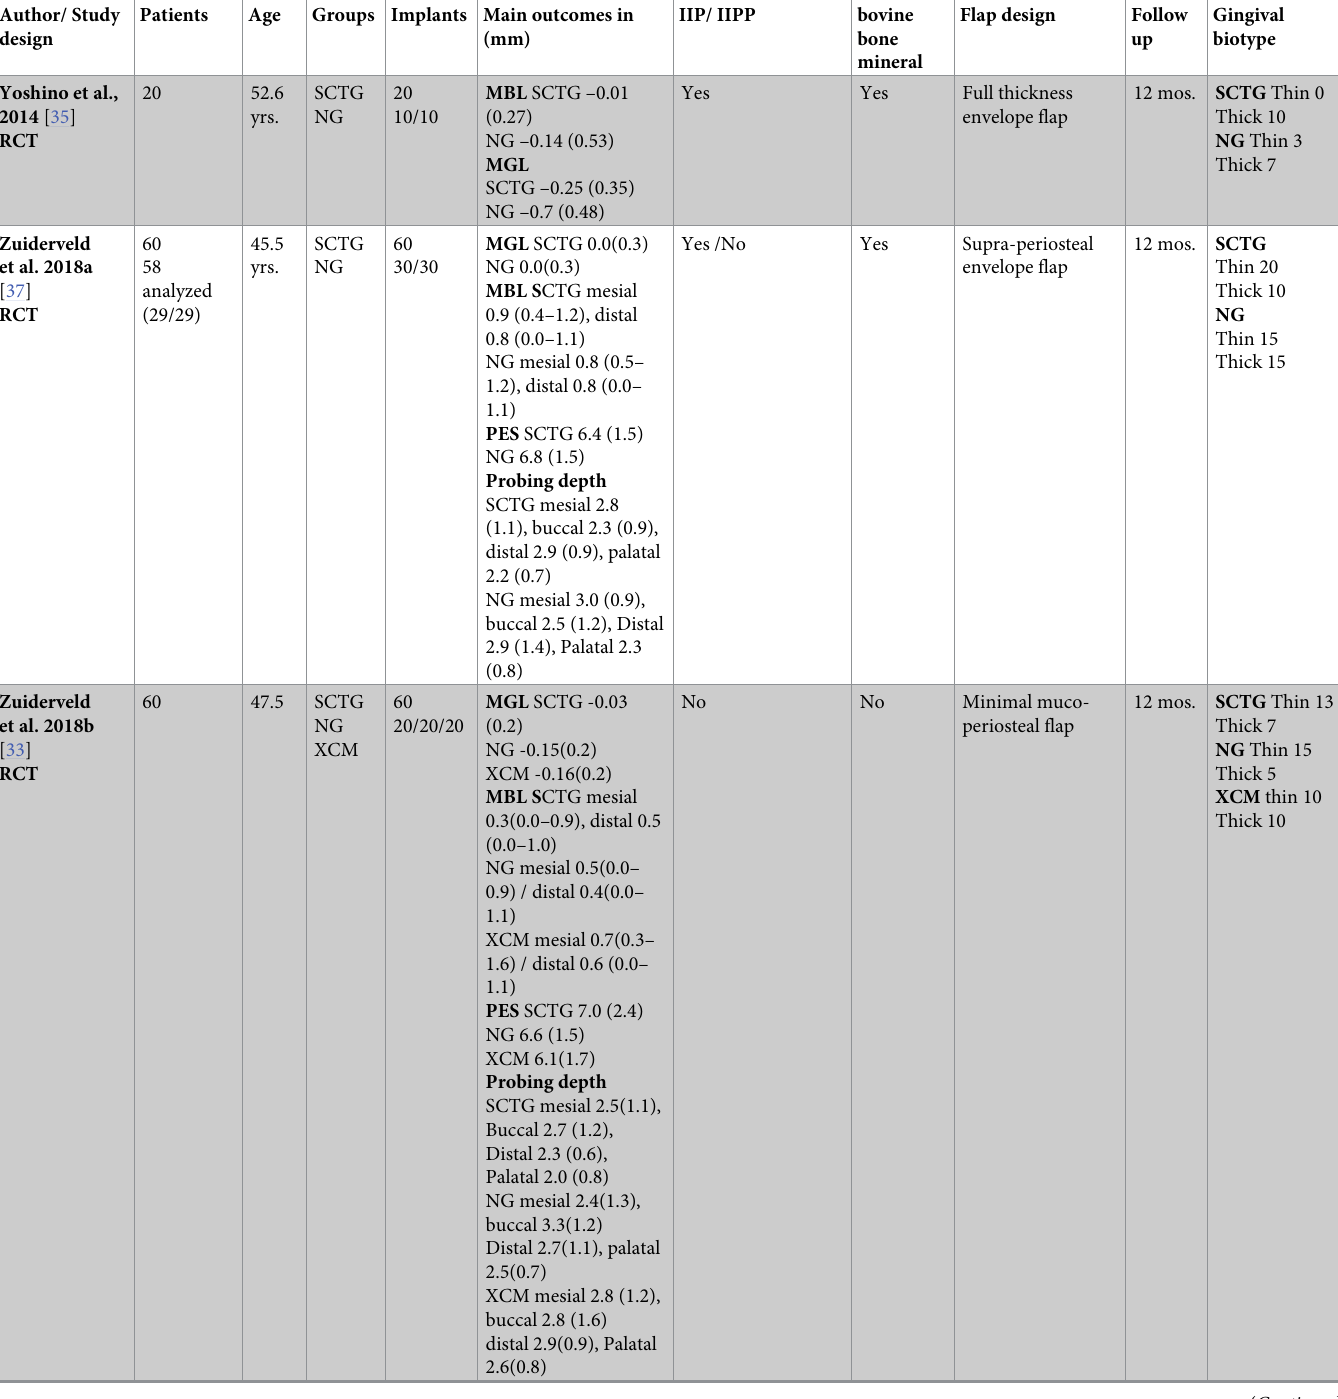
Table 1. Characteristics of the included